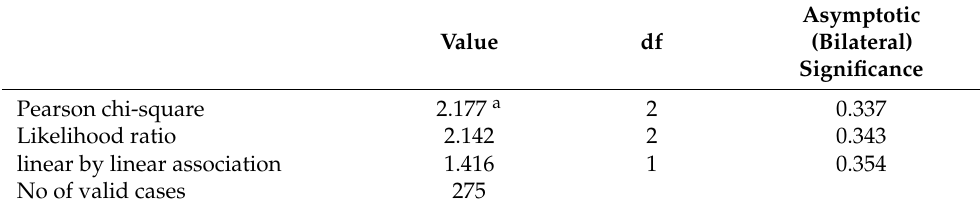
Table 16. Chi-square tests: remote work and working hours.